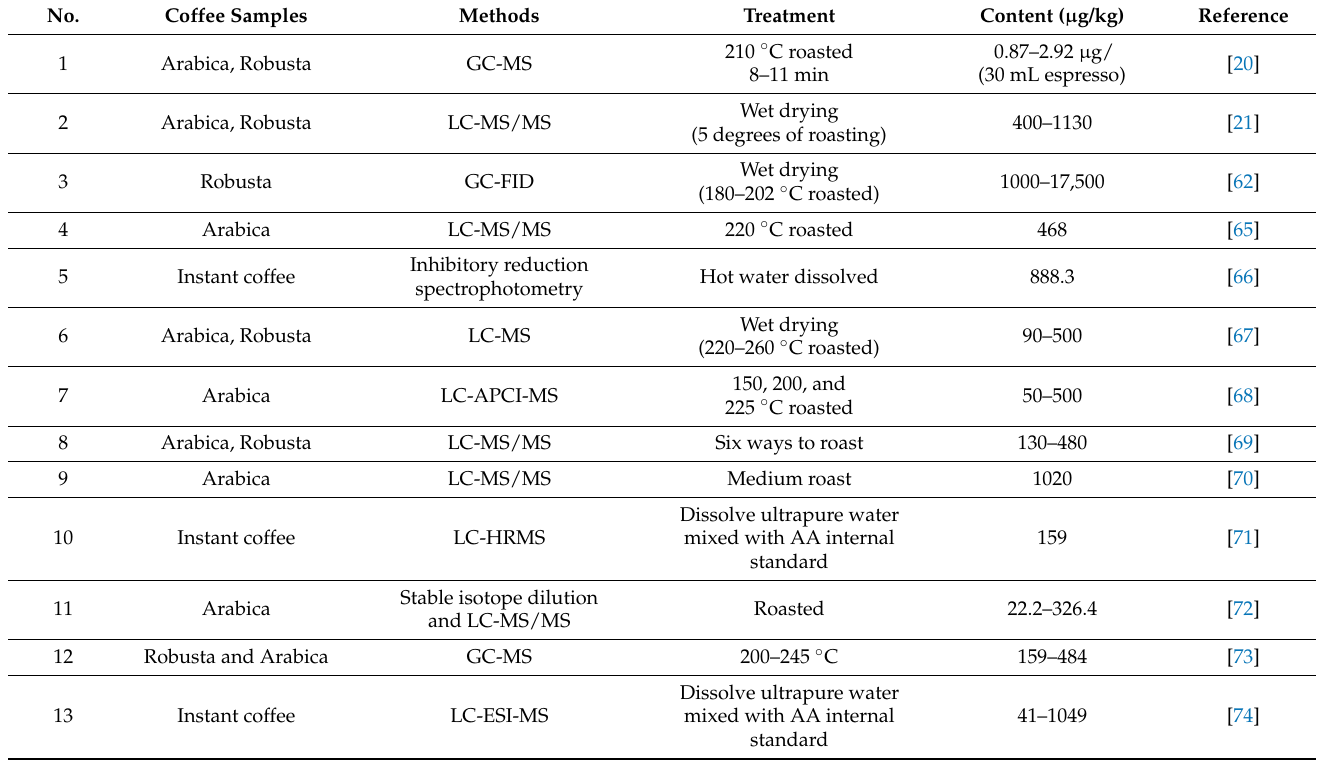
Table 1. A summary of studies in the literature regarding acrylamide detection methods in